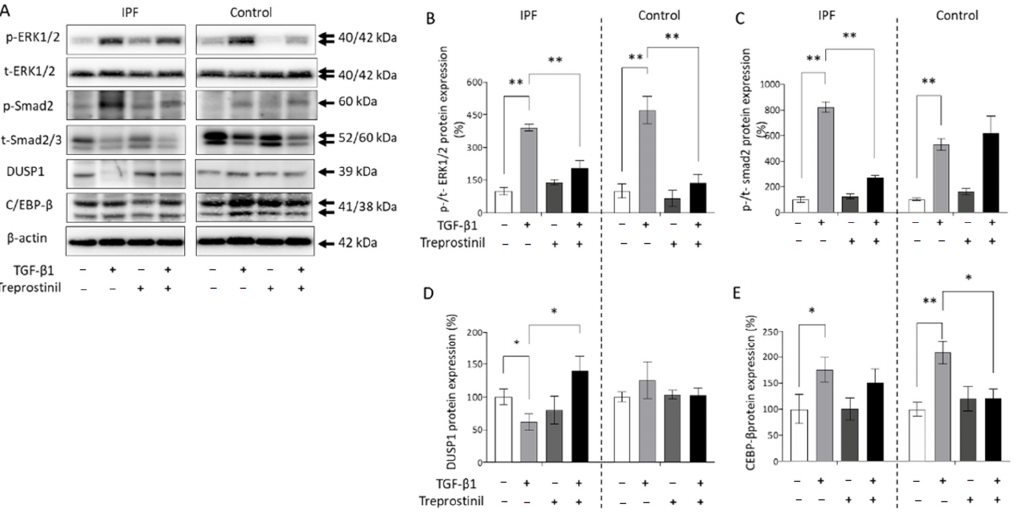
Figure 5. The effect of treprostinil and TGF- β 1-induced signaling and proliferation in control and IPF cells. ( A ) Representative Western blots obtained in cells isolated from IPF patients or controls. ( B ) Image analysis of Western blots ( n = 3) for the activation of Erk1/2 MAPK, ( C ) Smad2, ( D ) DUSP1, and ( E ) C/EBP- β . Bars represent mean ± SEM. * indicates p < 0.05, ** indicates p < 0.01. TGF- β 1 at 10 ng/mL, treprostinil at 1 × 10 − 8 M.